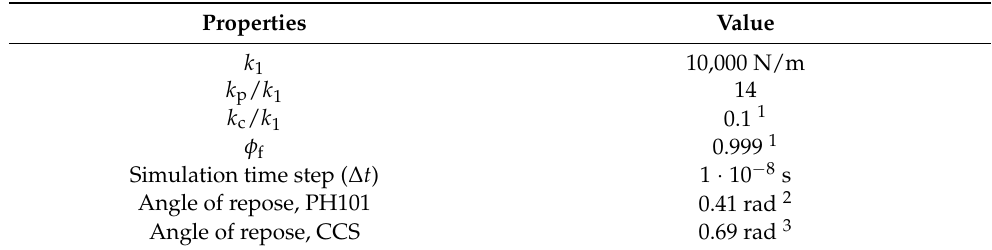
Table 5. Summary of the DEM parameters used for all simulations. k 1 and k p were identified through an optimisation